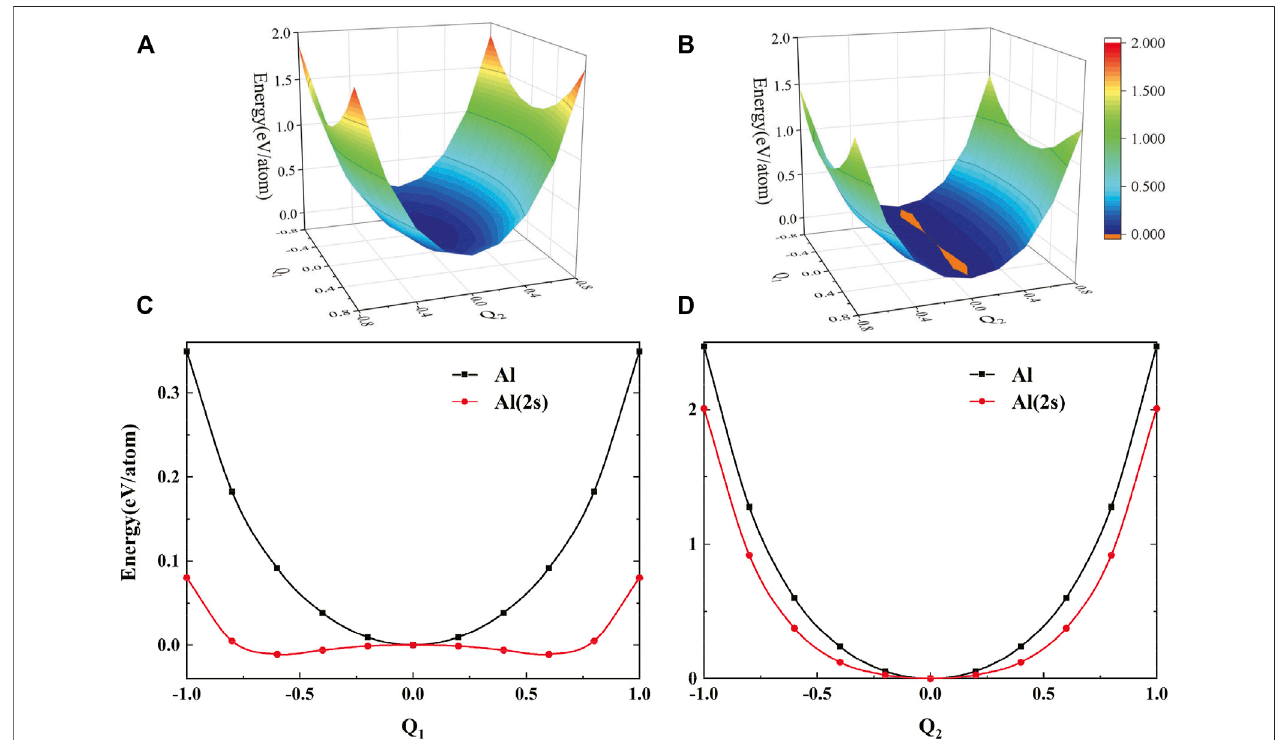
FIGURE 4 | PES of Al in the direction of the eigenvectors at high-symmetry point L. Q 1 and Q 2 correspond to dimensionless normal coordinates of the lowest TA mode and LA mode without (A) and with (B) a hole in the 2s orbital, respectively. (C) PES along the Q 1 direction with Q 2 = 0. (D) PES along the Q 2 direction with Q 1 = 0. The lattice energy is set as zero in the equilibrium